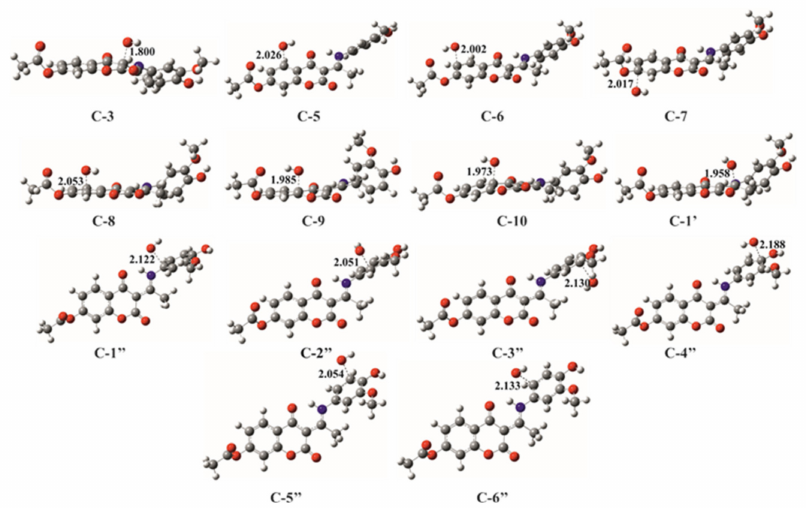
Figure 6. Optimized transition state geometries for the formation of radical adducts of A-4OH compounds in water at M06-2X/6-311++G(d,p) level of